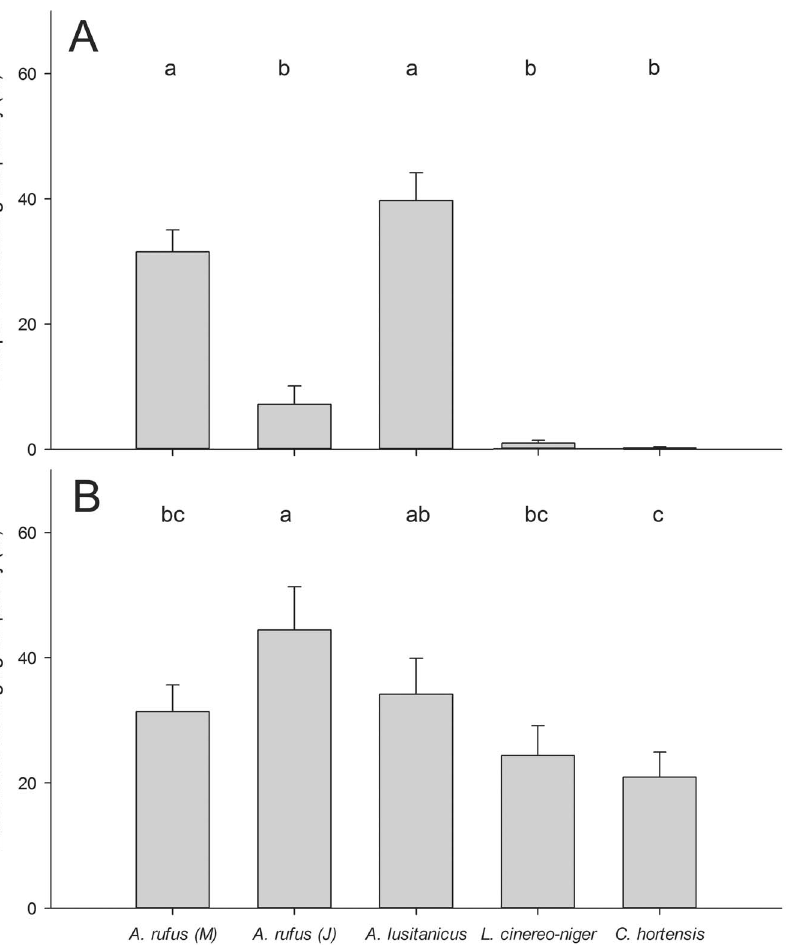
Figure 1. Comparison of diaspore swallowing and the elaiosome damaging frequency among gastropods. Comparison of (A) the diaspore swallowing frequency and (B) of the elaiosome damaging frequency among gastropod species. Swallowing of diaspores is considered as the potential dispersal ability of gastropods. Lamiastrum galeobdolon was not offered to all gastropod species and is not shown here. M, mature individuals; J, juveniles. Results are given as mean 6 standard error (SE). Results of GLMM analyses (Tukey contrasts) are shown for comparisons of diaspore and elaiosome feeding; treatments with different letters differ significantly at least at p , 0.05.